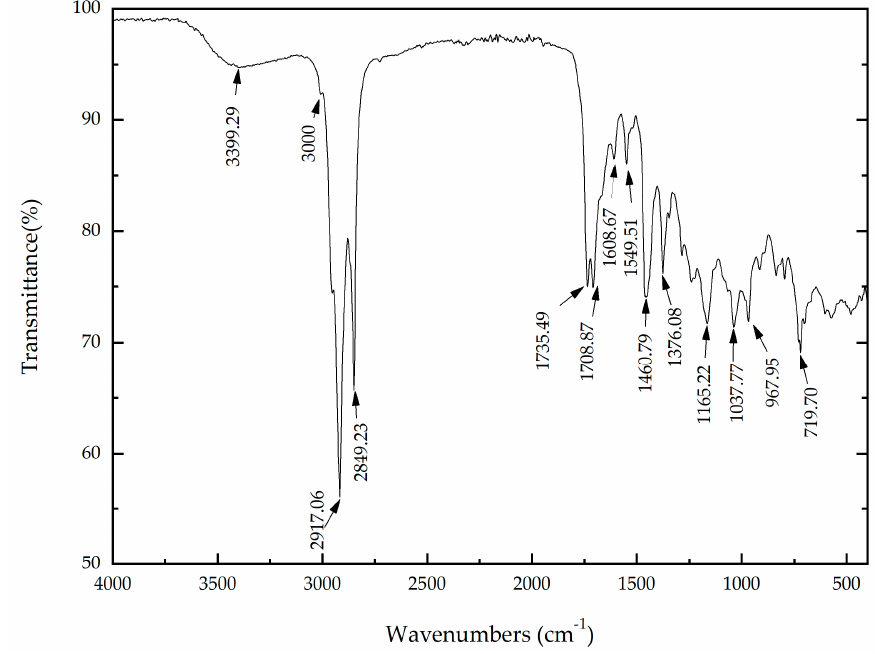
Figure 2. FTIR transmittance spectrum for Artemisia vulgaris extract. Table 1. FTIR spectrum identification for Artemisia vulgaris extract.